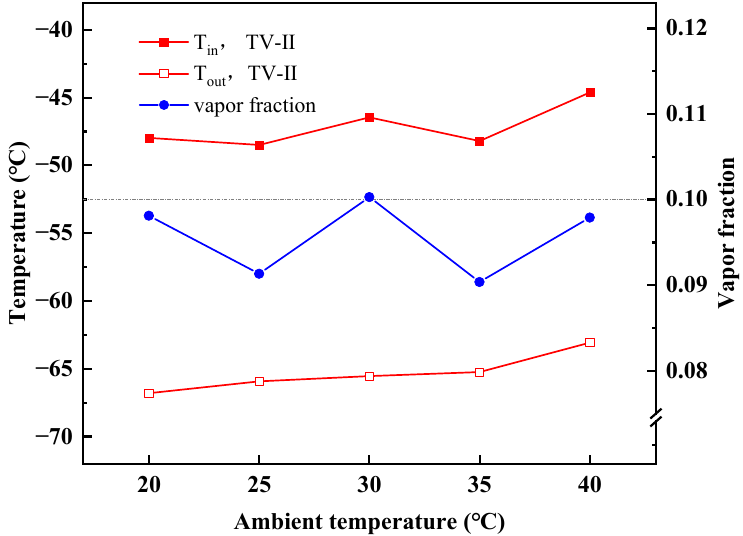
Figure 10. Parameters on the second throttle valve at different ambient temperatures.